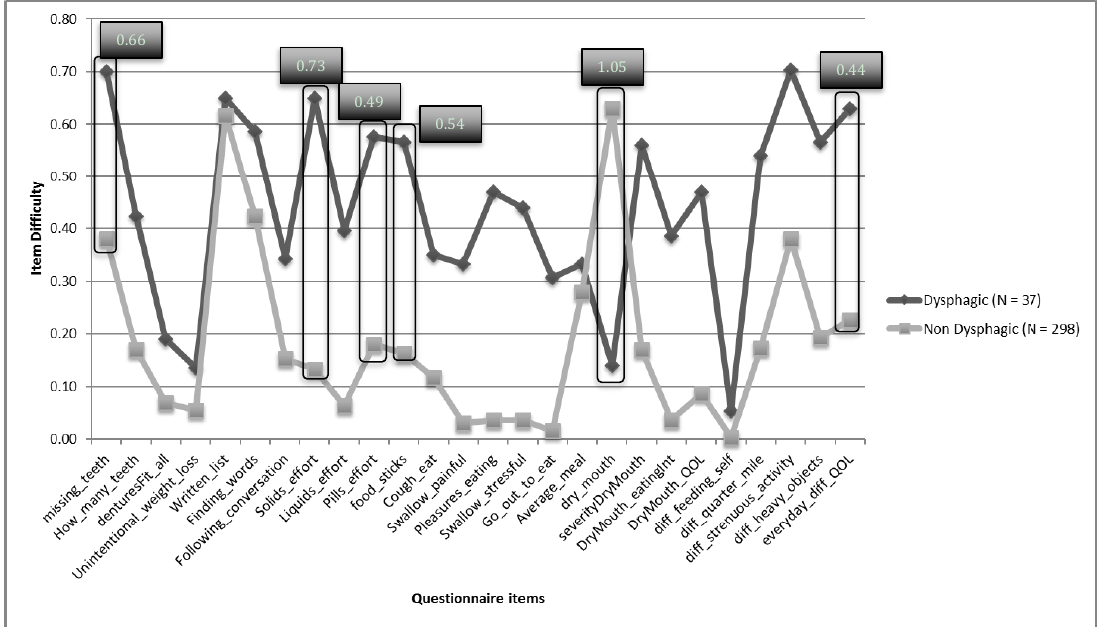
Figure 2 Item discrimination